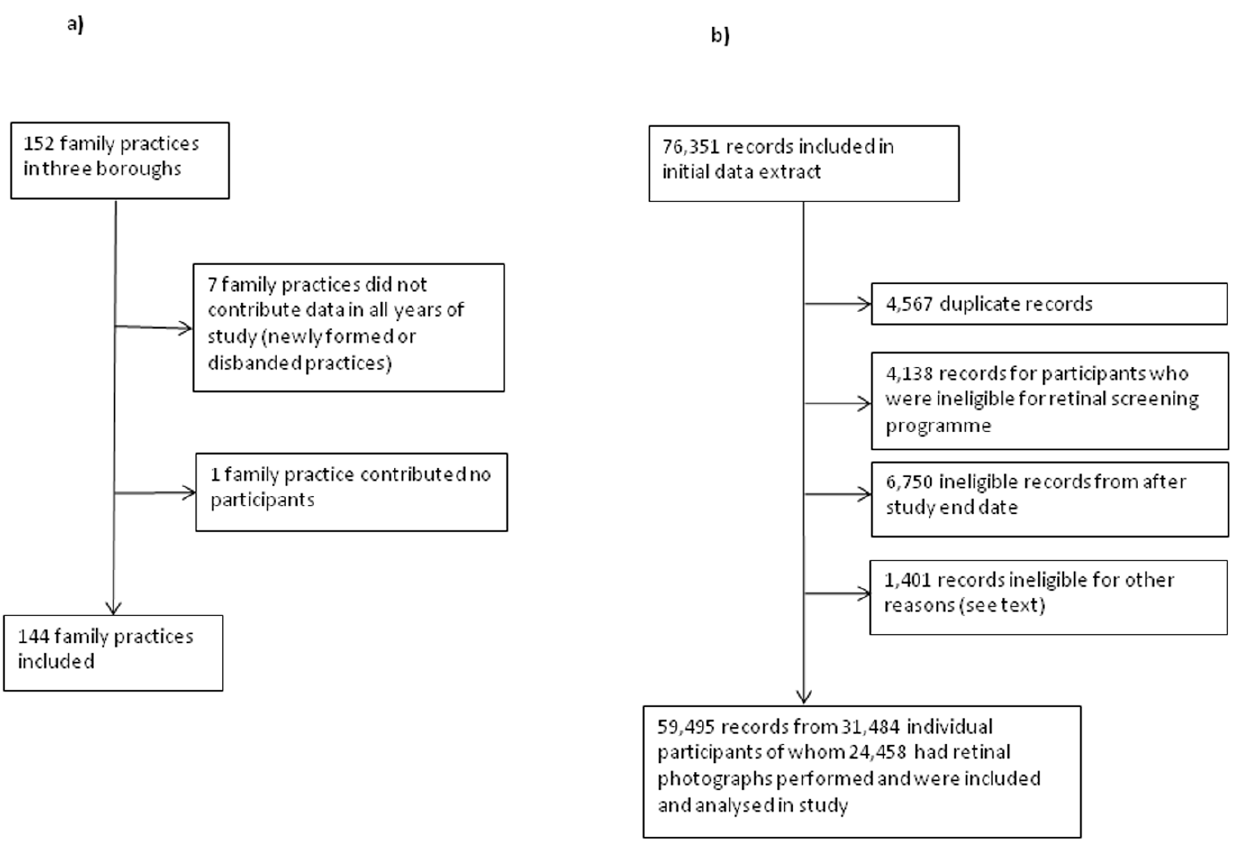
Figure 1. Flowcharts showing selection of family practices and screening records for analysis. Figure 1a): Selection of family practices. Figure 1b): Selection of records for analysis.